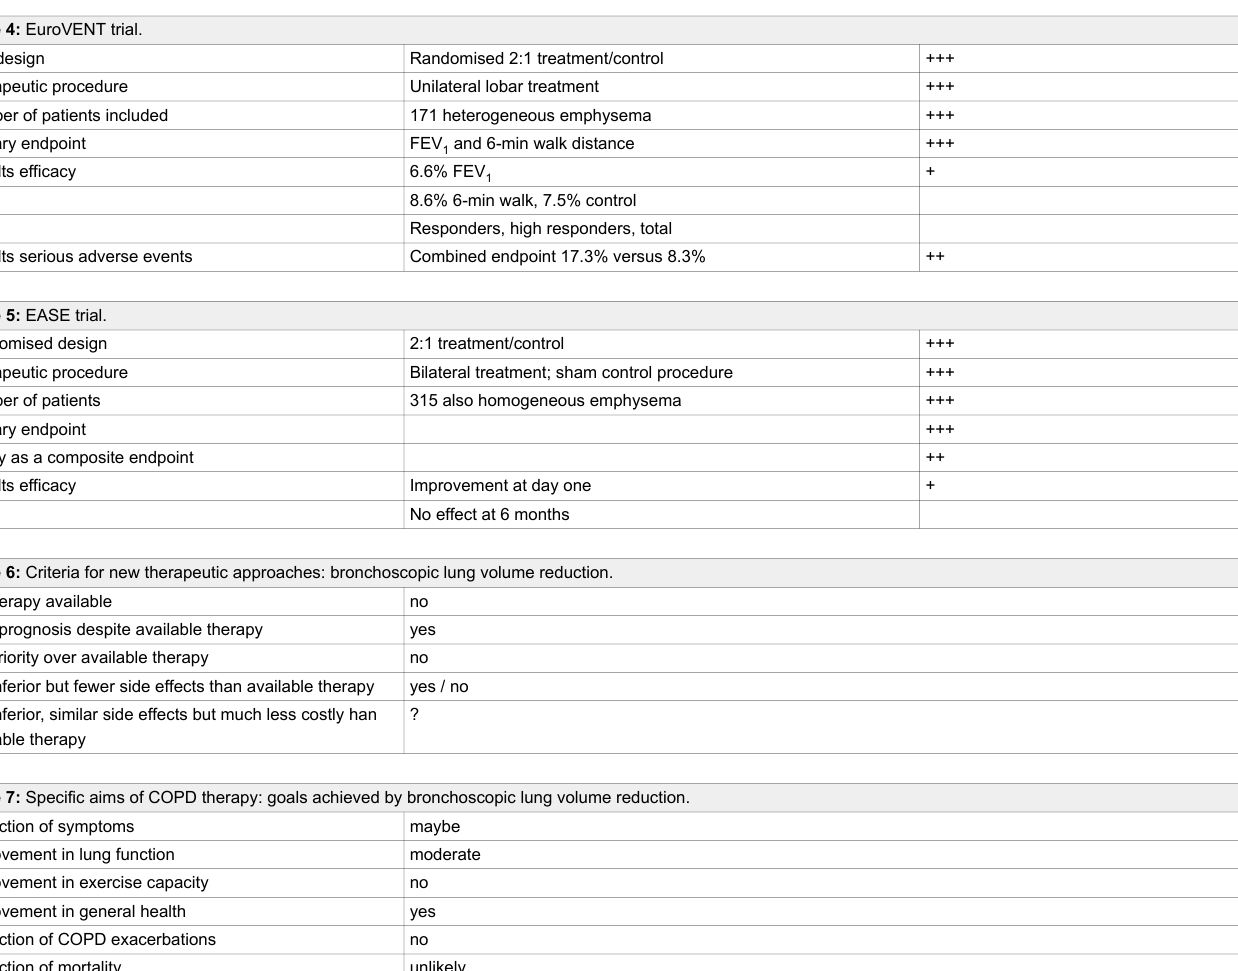
Table 7: Specific aims of COPD therapy: goals achieved by bronchoscopic lung volume reduction. Reduction of